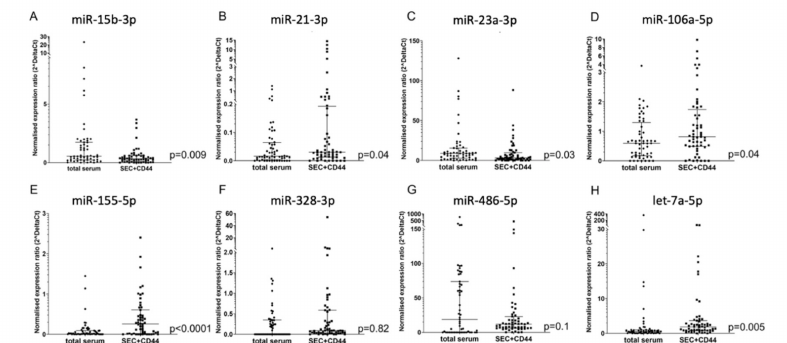
Figure 2. Comparison of microRNA detection in glioblastoma serum, depending on the source. ( A ) miR-15b-3p, ( B ) miR21-3p, ( C ) miR-23a-3p, ( D ) miR-106-5p, ( E ) miR-155-5p, ( F ) miR-328-3p, ( G ) miR-486-5p, ( H ) let-7a-5p. Depicted is the normalized expression ratio (2ˆdeltaCt) of eight microRNAs ( A – H ) in total serum and in SEC + CD44-purified EVs from the serum of glioblastoma patients ( n = 55). Expression levels were compared using a Wilcoxon rank sum test. Note that miR-15b-3p shows higher levels in total serum, as opposed to miR-21-3p and miR-106a-5p, which are upregulated in SEC + CD44 EVs. For miR-328-3p, no consistent up- or downregulation was observed between the two samples, which was partially because only 26 / 55 (47%) total serum samples were above the limit of detection. Bars depict the median value and the interquartile